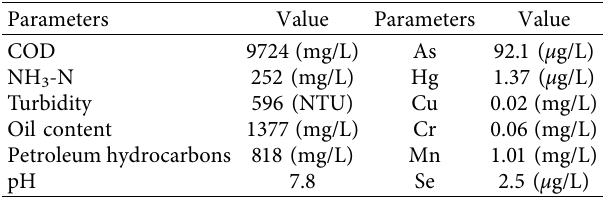
Table 1: Main water characteristics parameters of wastewater from TD of oil-contaminated soil in Tahe, Xinjiang,